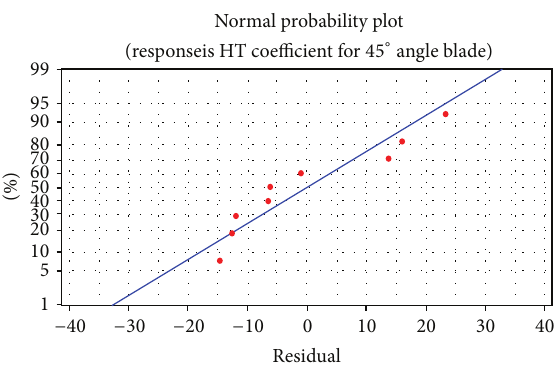
Figure 5: Normal probability plot (response is HT